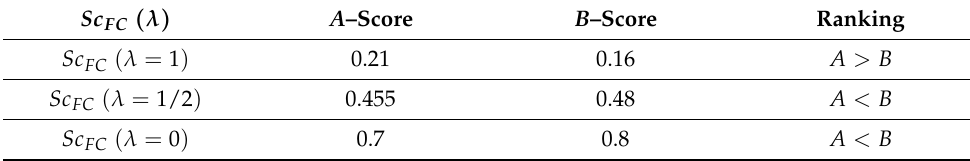
Table 4. The ranking of p − ROFS A = ( 0.3,0.3 ) and B = ( 0.2,0.2 ) as extended fuzzy sets (E-FSs) with new score